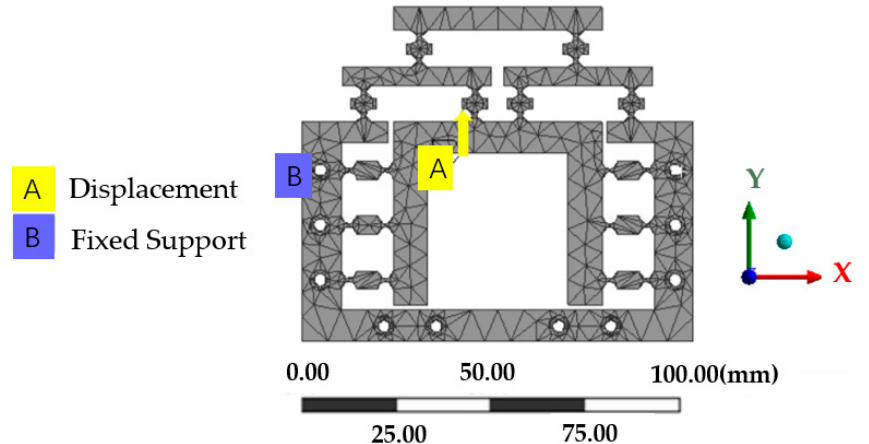
Figure 9. Fixed constraints and applied positive displacement of the y -axis.